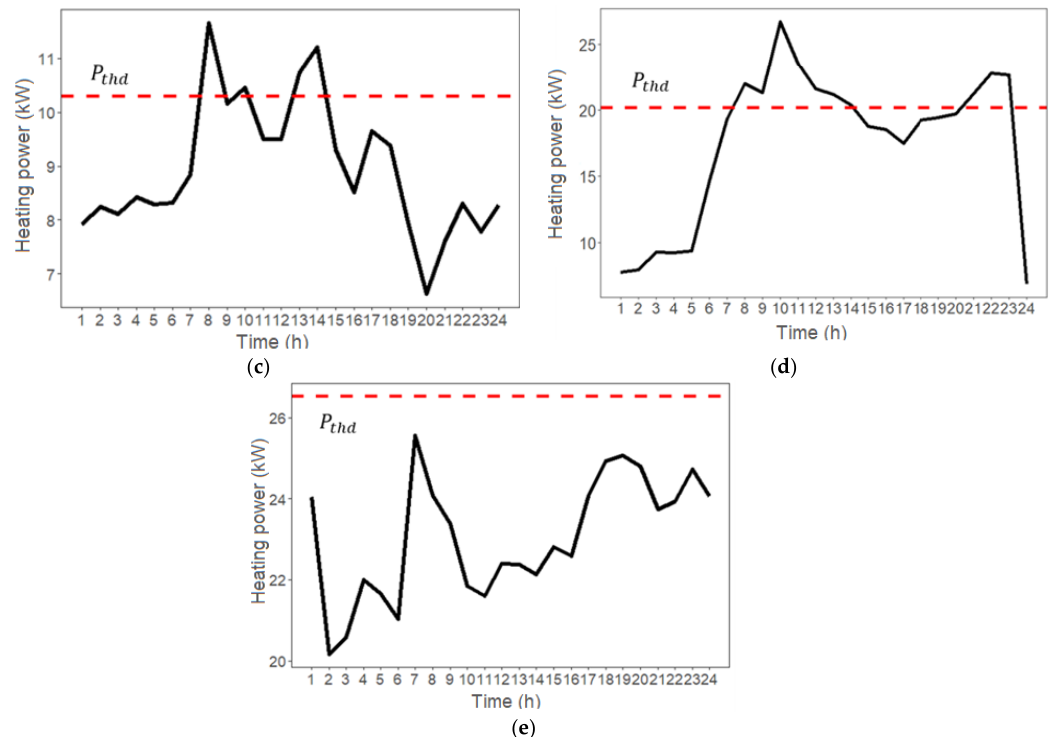
Figure 10. Typical hourly heating load profiles of each peak profile type. ( a ) Hat shape type; ( b ) Morning peak type; ( c ) Morning & afternoon peak type; ( d ) Morning & evening type; ( e ) No peak type.